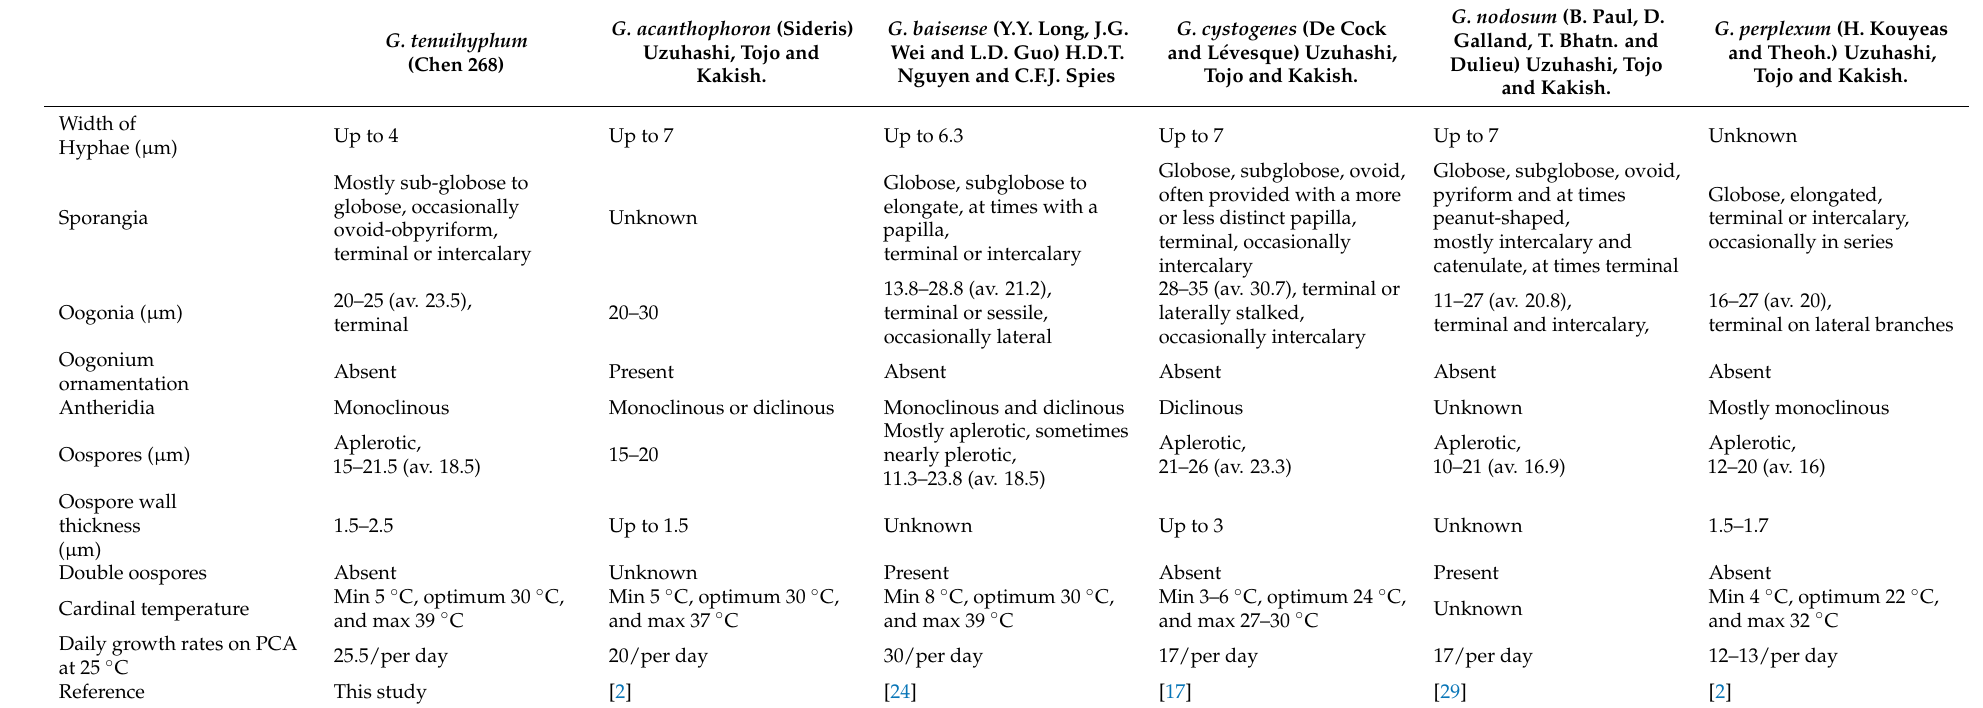
Table 3. Morphological description of Globisporangium tenuihyphum and the most closely related